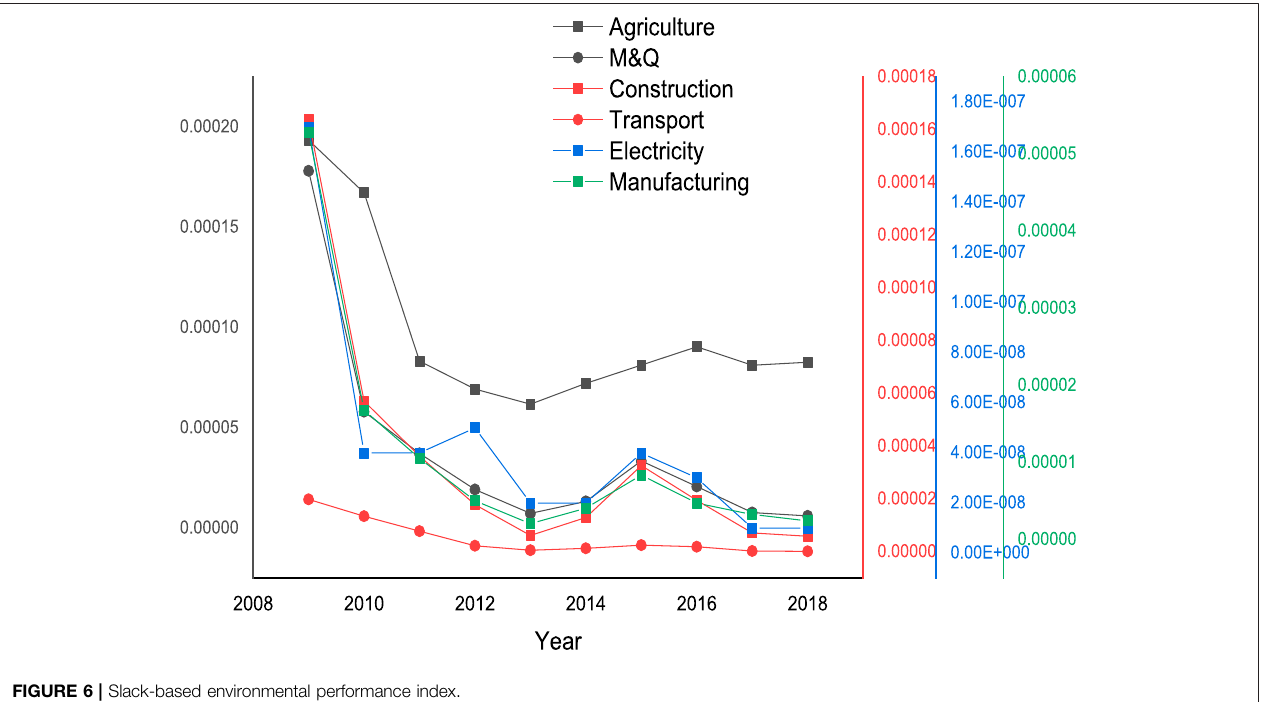
FIGURE 6 | Slack-based environmental performance index.